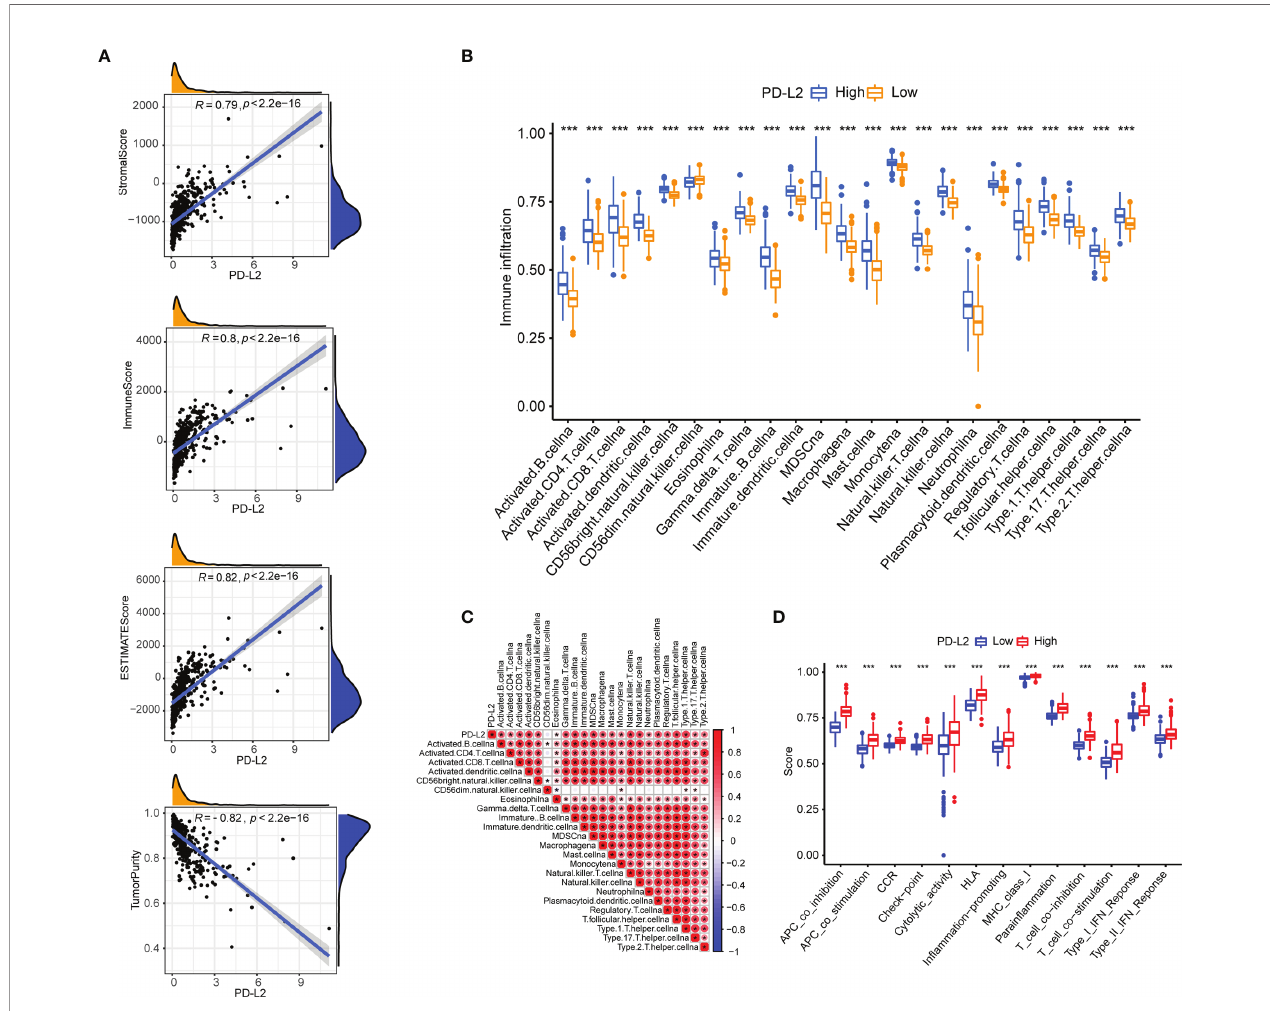
FIGURE 5 | The association of PD-L2 with the tumor immune microenvironment and immune status in the TCGA cohort. (A) PD-L2 was positively correlated with the stroma score, immune score, and ESTIMATE score, as well as negatively correlated with tumor purity in the TCGA cohort. (B) The abundance of tumor-in fi ltrating immune cells in the high-PD-L2 and low-PD-L2 expression groups. (C) Pearson correlation analysis ofPD-L2 expression and immune cell in fi ltration. (D) The immune pathway functions between the high- and low- expression patients.